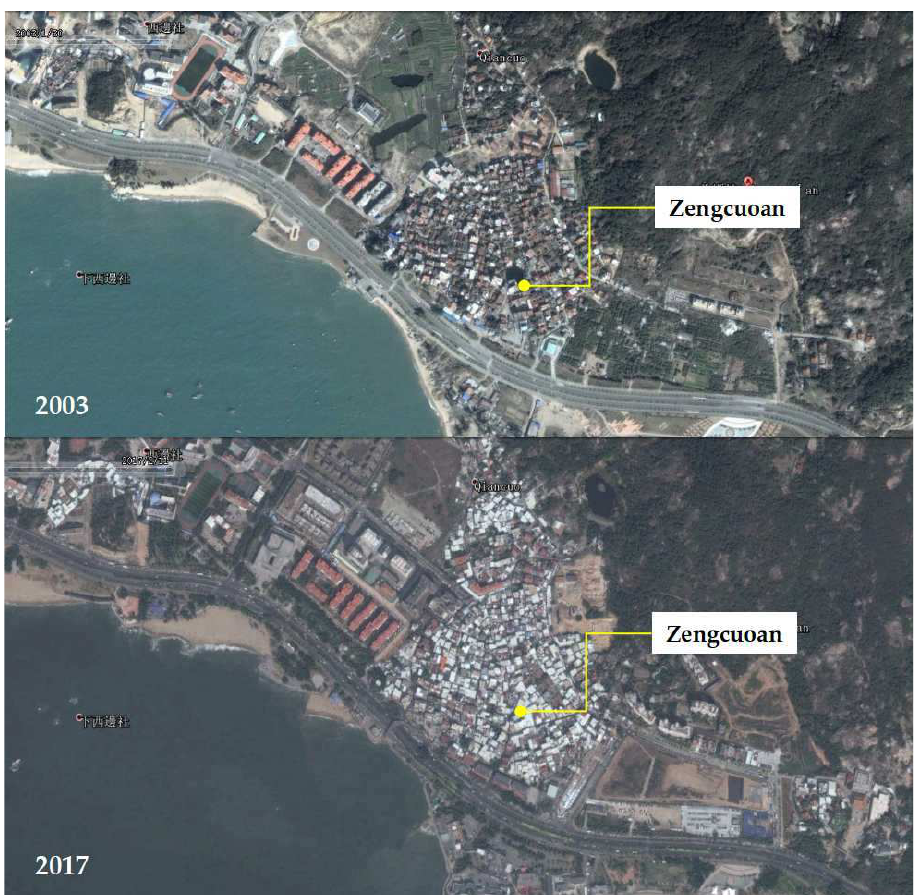
Figure 4. Satellite map of Zengcuoan in 2003 and 2017. Source: Adapted by the authors from Google Maps.